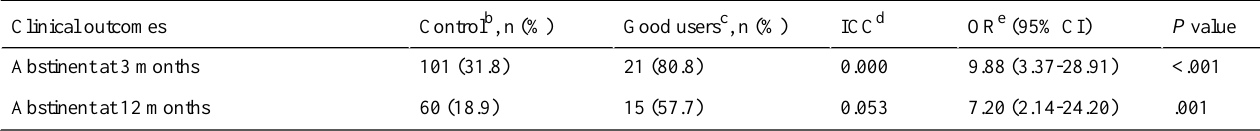
Table 4. Adjusted association in smoking cessation at 3 months and 12 months between control group and good users.